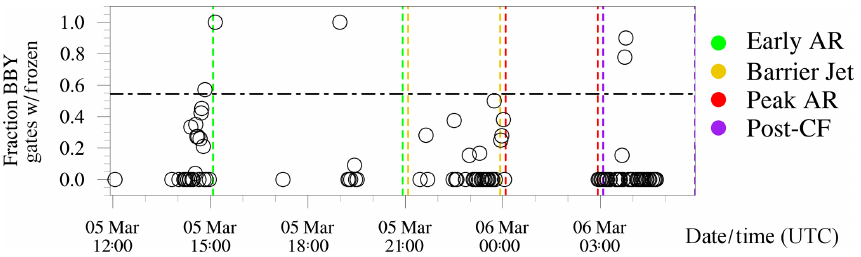
Figure 7. (a) Time series of P BBY (black circles) in the unblocked layer from all KDAX scans detecting precipitation at the BBY azimuth. frz The all-storm mean of P CZC is shown by the horizontal dot–dash black line. Vertical dashed lines show the boundaries of kinematic periods, frz as coded by color in the